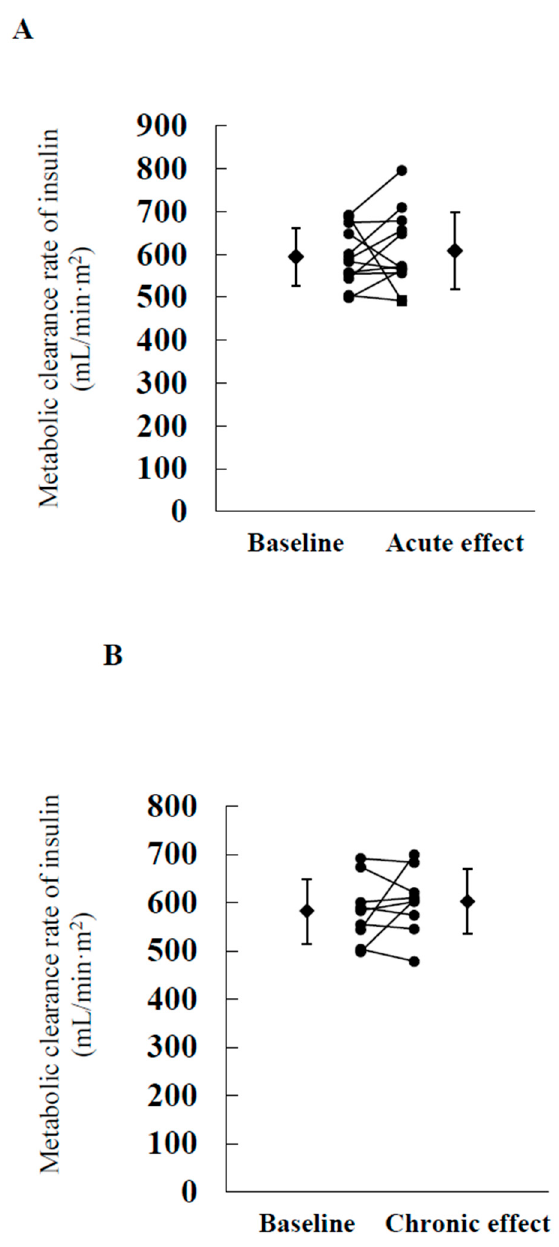
Figure 2. Changes in metabolic clearance rate of insulin in the acute effect study ( A ) and chronic effect study ( B ). ( A ) Metabolic clearance rate of insulin at baseline and after a single dose of tofogliflozin in 12 patients. ( B ) Metabolic clearance rate of insulin at baseline and after 8 weeks of treatment with tofogliflozin in nine